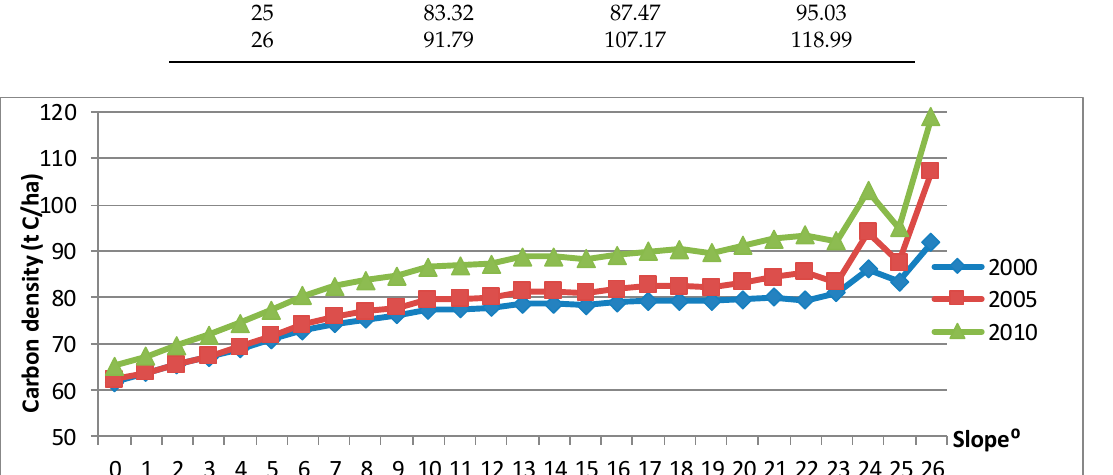
Figure 7. Relationship between slope and carbon density on the Loess Plateau.